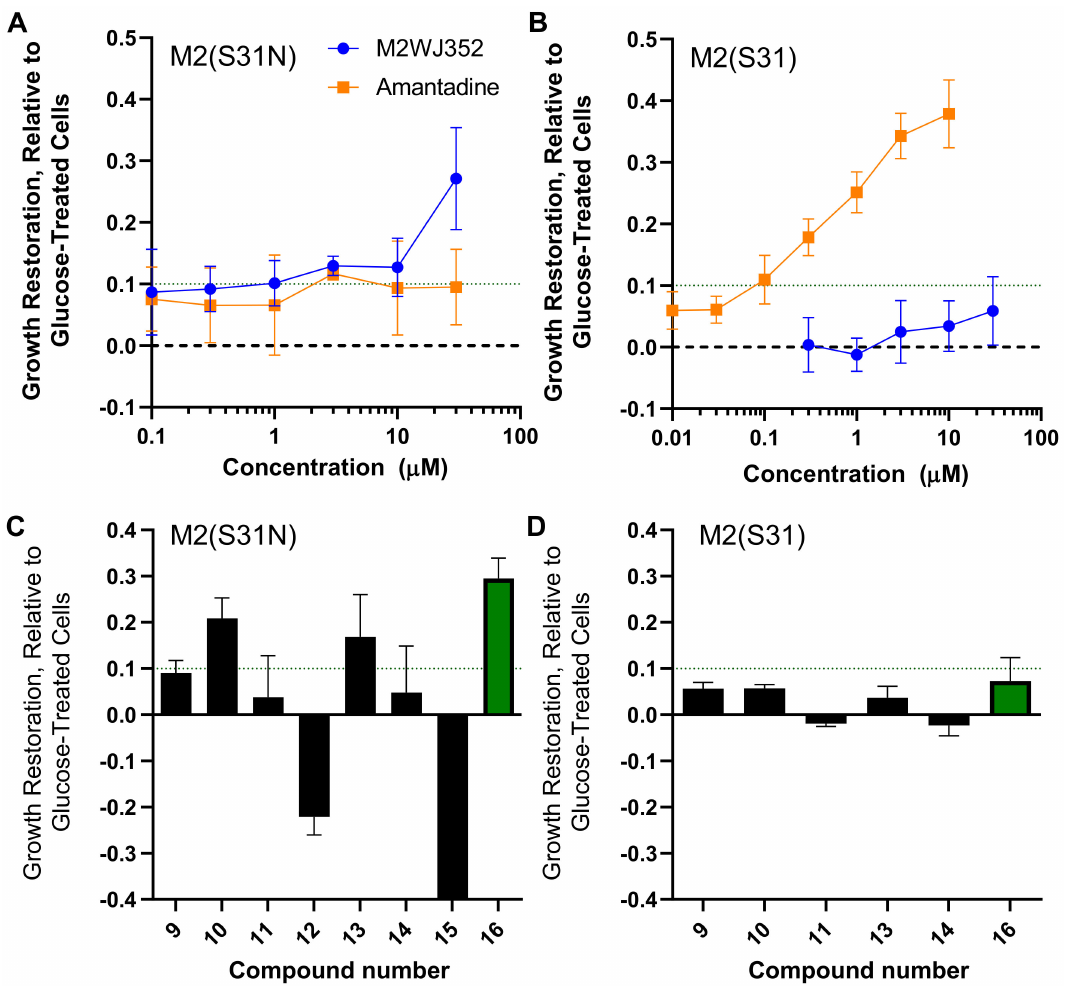
Figure 3. Ability of compounds to restore growth in yeast expressing M2. ( A , B ) Restoration of yeast growth in M2(S31N) ( A ) and M2(S31)-expressing cells ( B ) in the presence of the control M2(S31N) inhibitor M2WJ352 and control M2(S31) inhibitor amantadine. ( C , D ) restoration of yeast growth in M2(S31N) ( C ) and M2(S31)-expressing cells ( D ) in the presence of natural products shown in Figure 2 (compounds 9 – 16 ). E ff ects of chebulagic acid are highlighted in